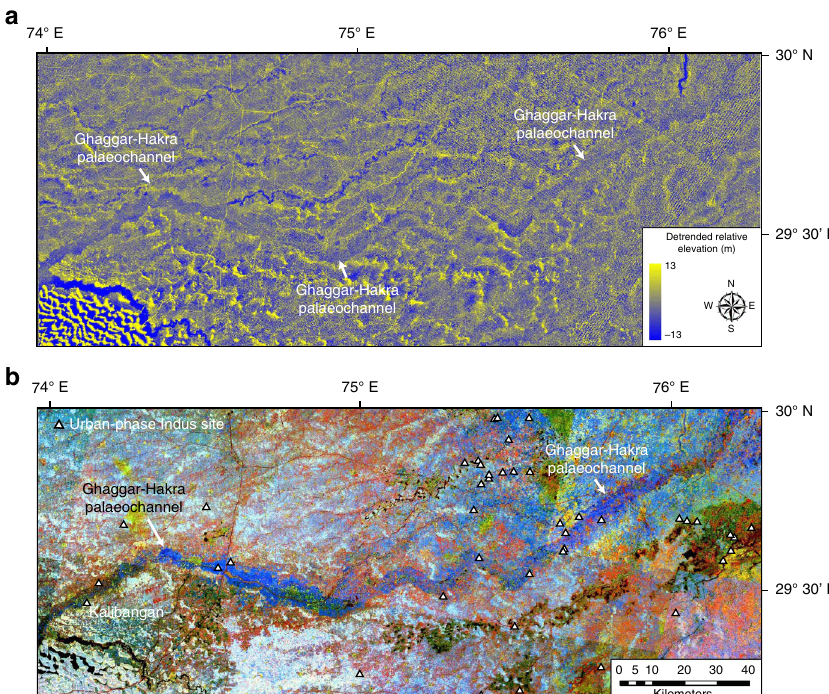
Fig. 3 Topography of Ghaggar – Hakra palaeochannel. a Detrended relative elevation map of Sutlej – Yamuna drainage divide, derived from NASA Shuttle Radar Topography Mission (SRTM) 53 30 m DEM (2014 release) showing that Ghaggar – Hakra palaeochannel forms an incised valley. b Corresponding TM colour composite image (detail of Fig. 2) showing correspondence of Ghaggar – Hakra palaeochannel and incised valley. Locations of urban-phase Indus settlements along Ghaggar – Hakra palaeochannel are